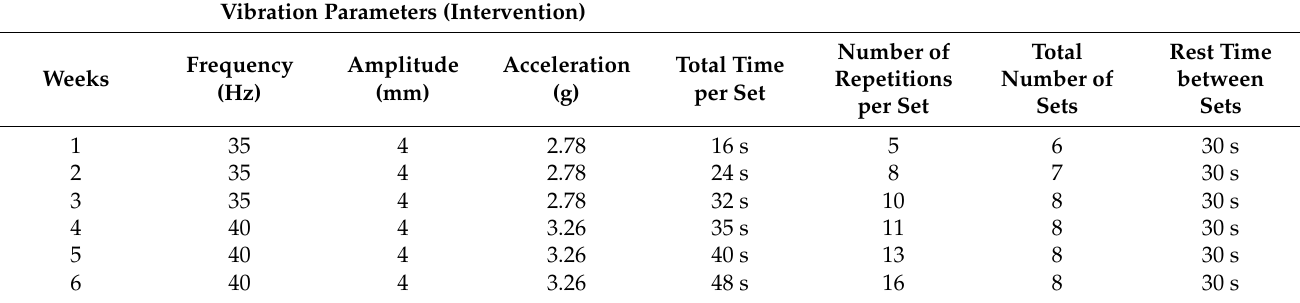
Figure 2. The whole-body vibration training (WBVT). Synchronous vibrating platform and positioning during experimental conditions. ( A ) Synchronous vibrating platform, arrows indicating distance 14 cm to the right and 14 cm to the left of the platform’s vibration center and fixed distance to ensure that each lower limb received the same amount of vibration stimuli; ( B ) flexion, or down, for each squat for 3 s (angle 60 ◦ ); ( C ) extension, or up, for 3 s (angle 10 ◦ ). Table 1. Whole-body vibration training load program (adapted from